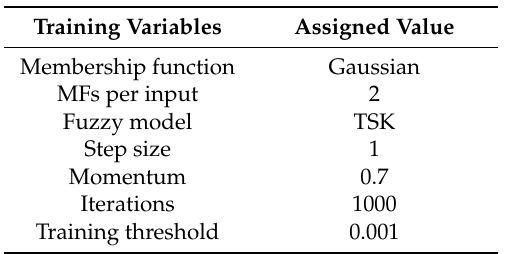
Table 4. Configurations of CANFISM during